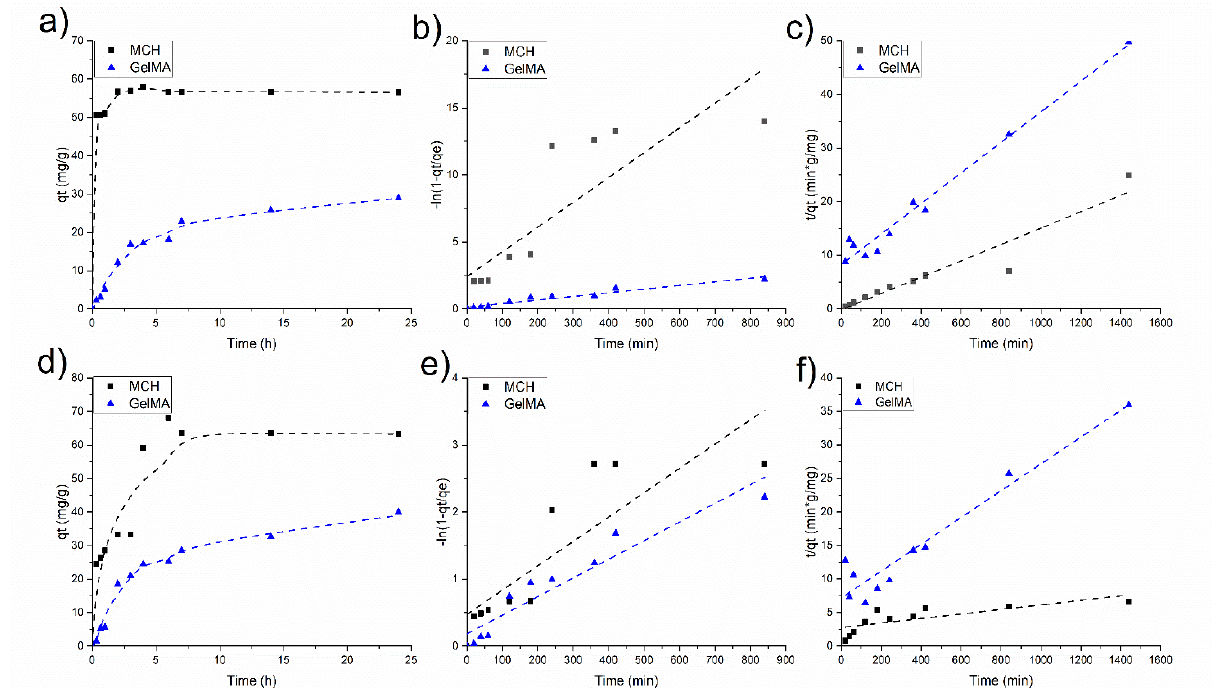
Figure 10. Pb(II) adsorption kinetics at ( a ) 50 mg/L and ( d ) 75 mg/L of initial concentration; ( b , e ) data fitted using the pseudo-first-order kinetic model with 50 mg/L and 75 mg/L of C 0 , respectively, ( c , f ) data fitted using the pseudo-second-order kinetic model with 50 mg/L and 75 mg/L of C 0 , respectively.